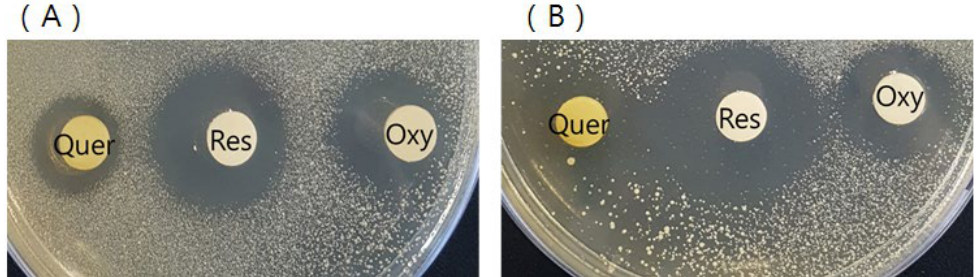
Figure 4. Antimicrobial effect of isolated compounds (Quer; quercetin, Res; resveratrol, and Oxy; oxyresveratrol) against C. acnes KCTC3314 ( A ) and C. acnes KCTC3320 ( B